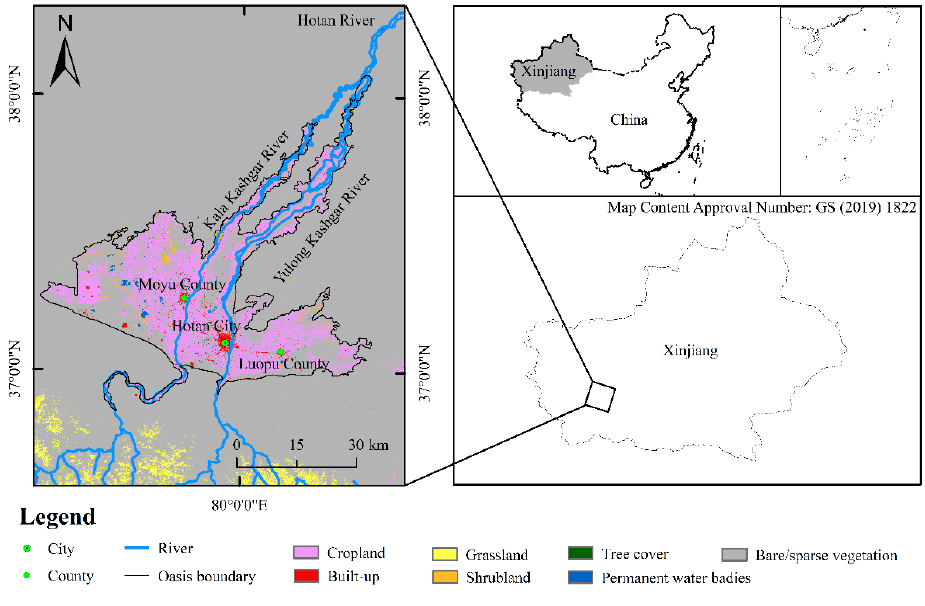
Figure 1. Overview of the study area. Table 1. Transfer matrix of land use/cover area in Hotan Oasis from 2000 to 2020 (unit: km 2